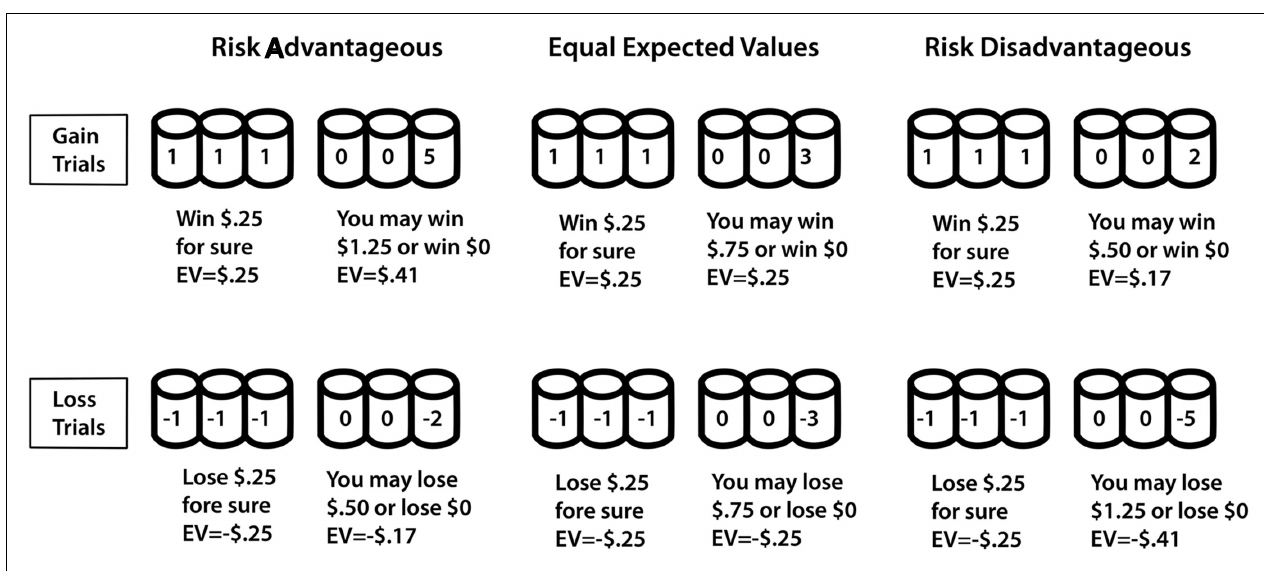
FIGURE 2 | Samples of trial types on the cups task. Note: in each case the “riskless” side is depicted on the left and the “risky side” is depicted on the right. In the experiments these were counterbalanced over trials.